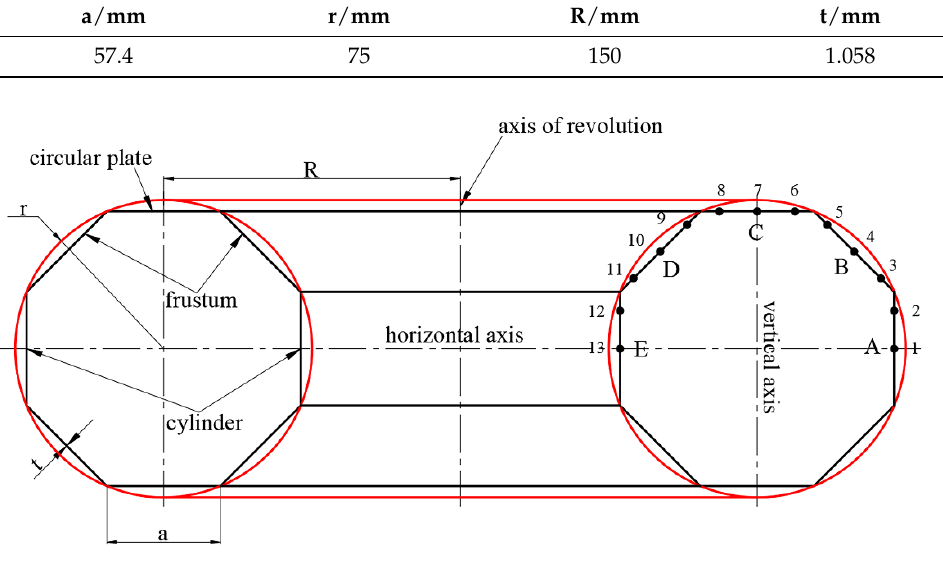
Figure 1. Schematic of toroidal pressure hulls with discrete octagonal cross-sections (black lines) and continuous circular cross-sections (red lines).